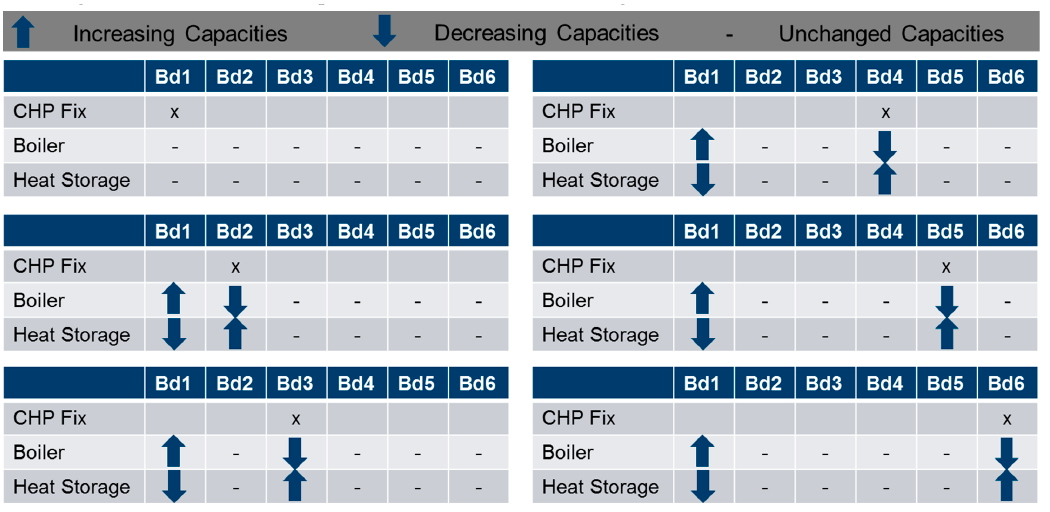
Table 4. Impact of different fix CHP locations on the TAC.